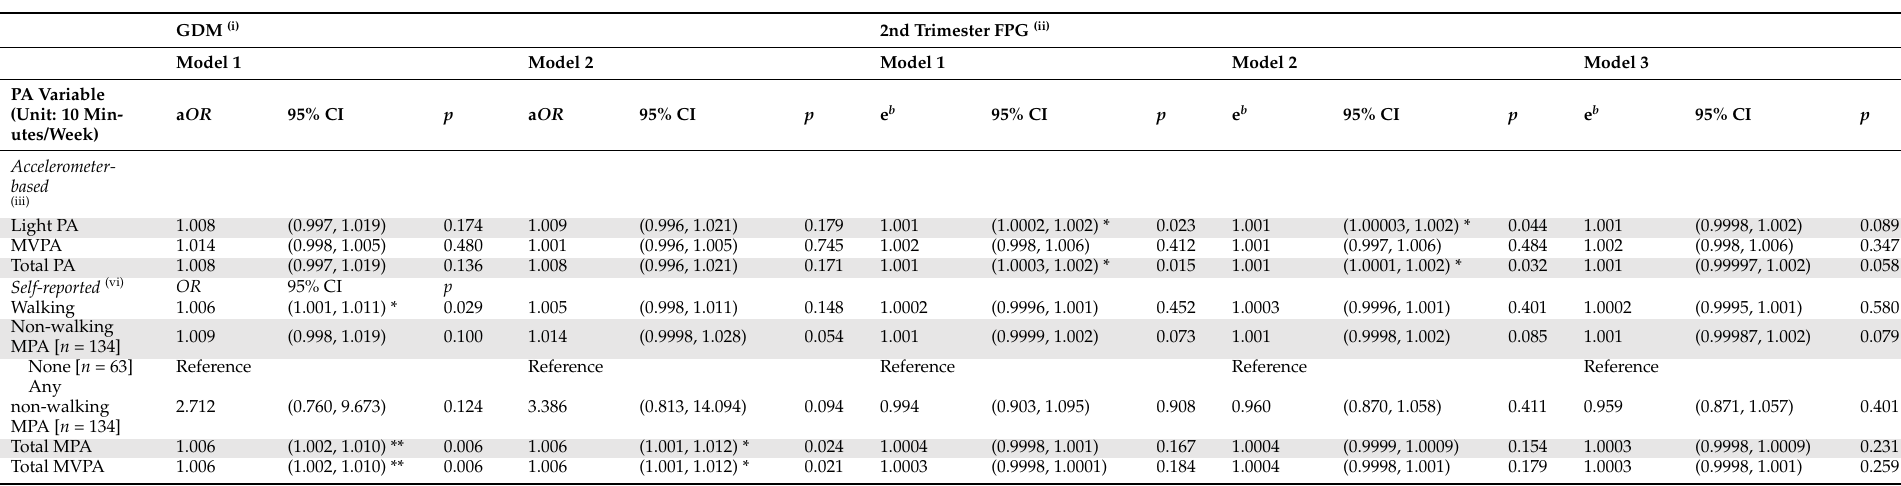
Table 4. Association of physical activity (PA) variables at 2nd trimester with diagnosis of gestational diabetes mellitus (GDM) and 2nd trimester fasting plasma glucose (FPG) ( N = 197).